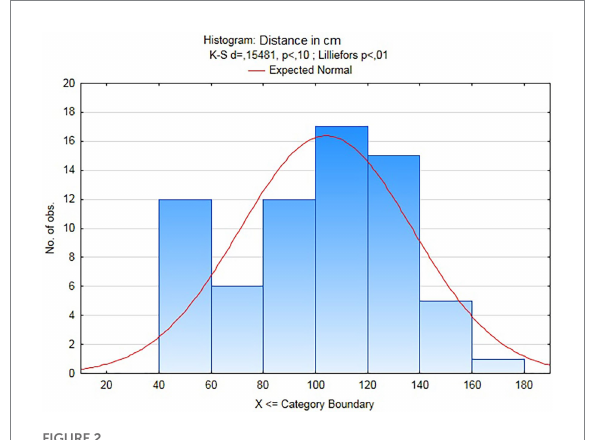
FIGURE 2 Communication distances chosen by